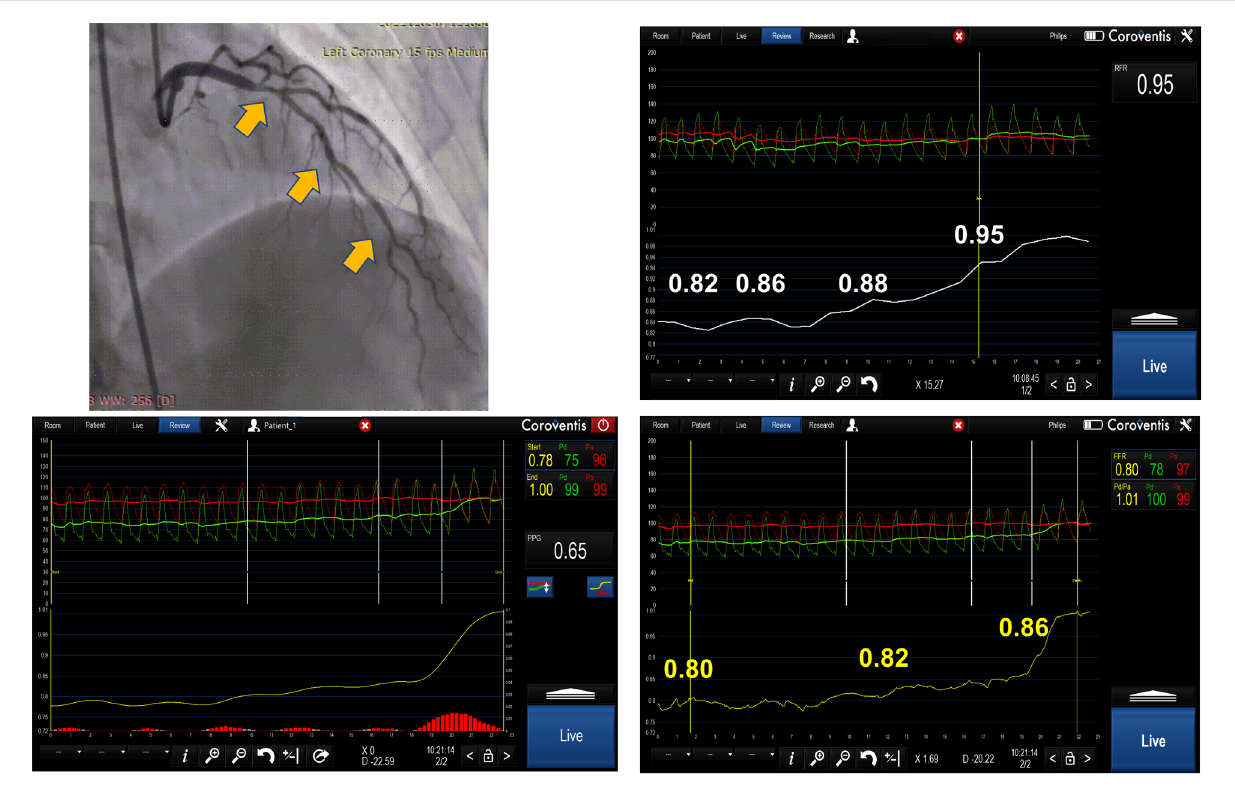
FIGURE 5 The image represents serial lesion assessment in a 39 year-old patient using resting full-cycle ratio (RFR) and FFR pullback with papaverine as the hyperemic agent. The obtained values were abnormal for RFR and normal for FFR. The possible reason for this could be that there was a diffuse atherosclerotic disease and pullback pressure gradient (PPG showing an intermediate value of 0.65) and the operator decided to defer revascularization due to a normal FFR value and diffuse disease in the left main and LAD.